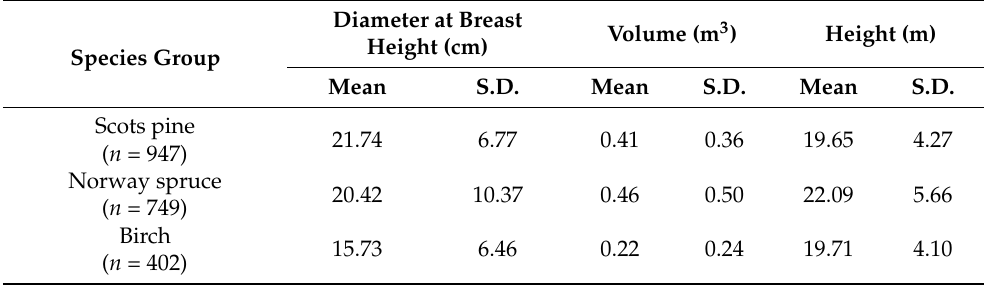
Table 3. Field-measured species-specific descriptive statistics of the matched trees at T2. The Mean and standard deviation (S.D.) values of the diameter at breast height (dbh), volume, and height are